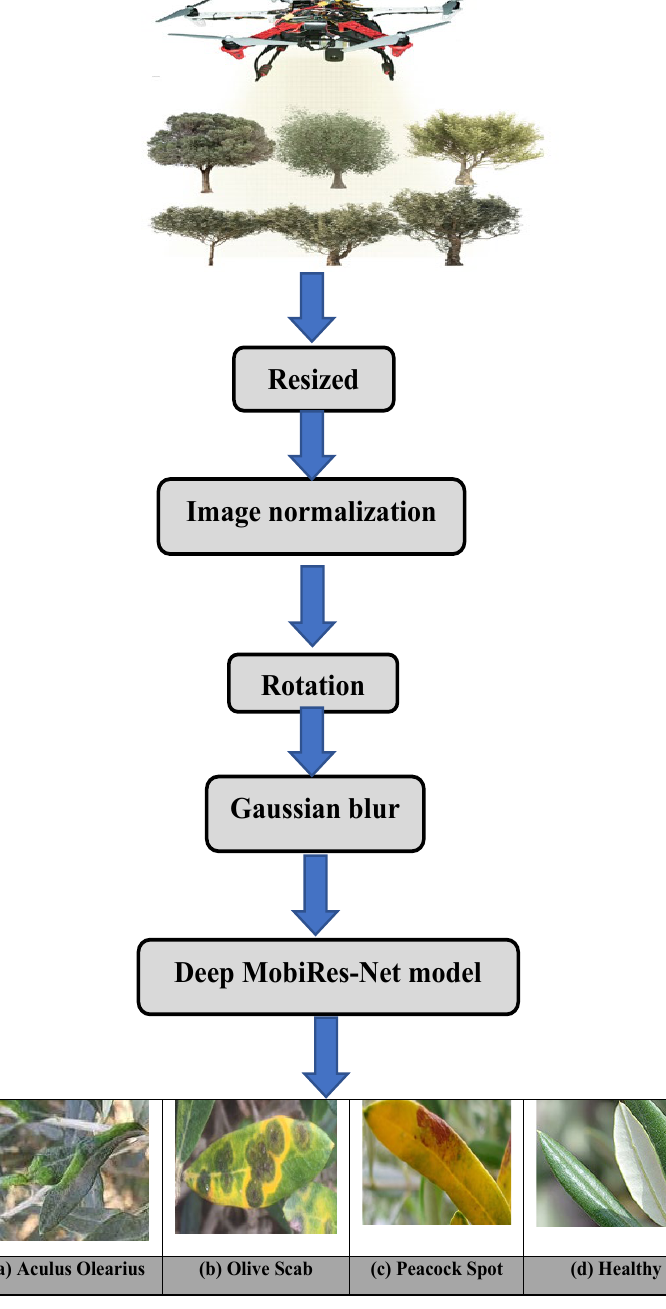
Figure 3. Schematic view of the proposed olive diseases detection method.